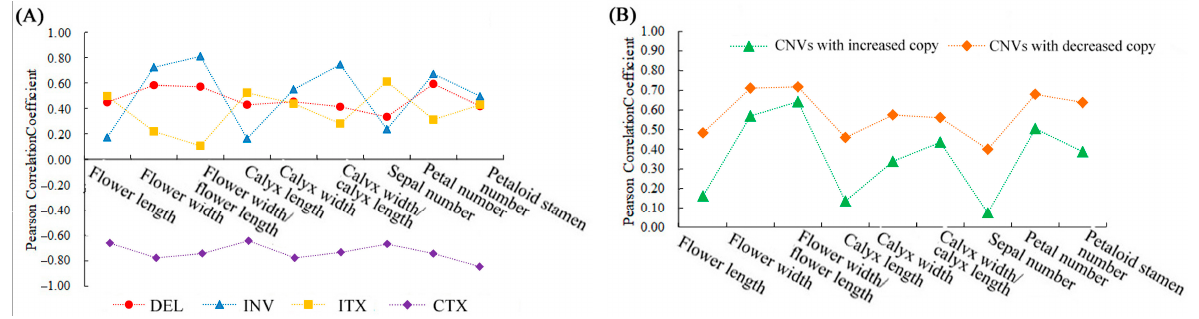
Figure 7. The correlation coefficient between SV/CNV types and morphological parameters. ( A ) The correlation coefficient between SV types and morphological parameters; ( B ) the correlation coefficient between CNV types and morphological parameters.